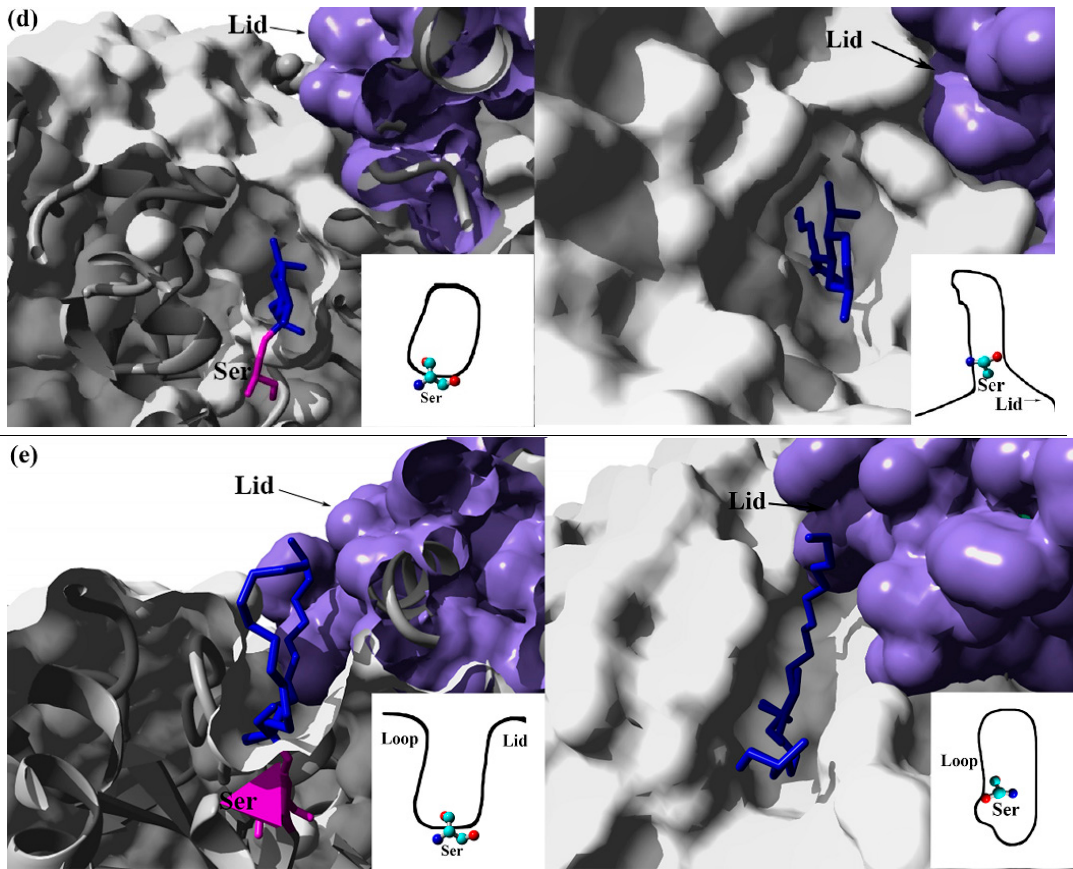
Figure 3. Shapes of the five types of binding sites of lipases as identified by Pleiss & Fischer [7]. ( a ) Pseudomonas aeruginosa PAO1 (PDB: 1EX9) [82]. ( b ) Candida antarctica lipase B (PDB: 1LBS) [83]. ( c ) Rhizomucor miehei lipase (PDB: 4TGL) [84]. ( d ) Candida rugosa lipase (PDB: 1LPM) [66]. ( e ) Human pancreatic lipase (PDB: 1LPB) [85]. The purple surface represents the lid structure. The residue color in magenta represents the catalytic Ser. The residue color in blue represents the substrate. (Figures prepared by http://www.yasara.org).